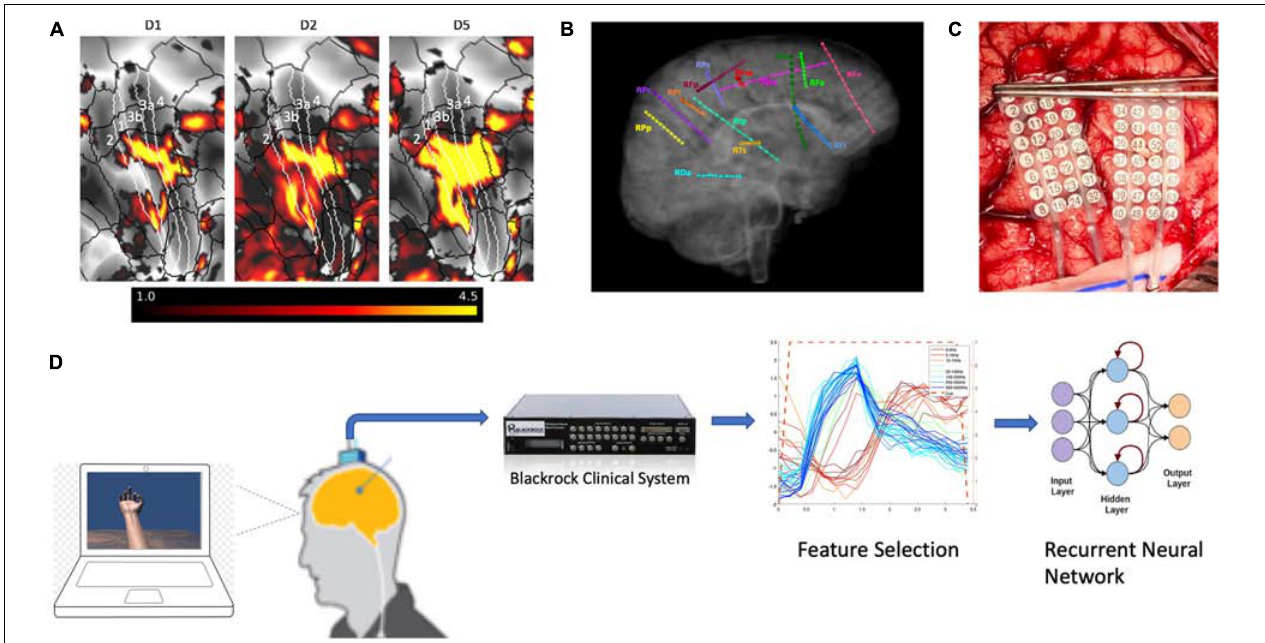
FIGURE 1 | Functional magnetic resonance imaging and electrode placement. (A) Pre-surgical fMRI obtained while participant P1 pressed different buttons on a handheld device while watching videos showing desired movements. (B) Exemplary placement of SEEG electrodes (participant 3). (C) Photograph of HD ECoG electrode placement for recordings in participant P1_03. (D) Experimental setup where participants received visual cues of hand movements on a laptop computer with cues lasting 3 or 4s followed by a 3 or 4s period of rest; the clinical recording system (Natus Medical, Inc.) is not shown and was always connected for continuous data